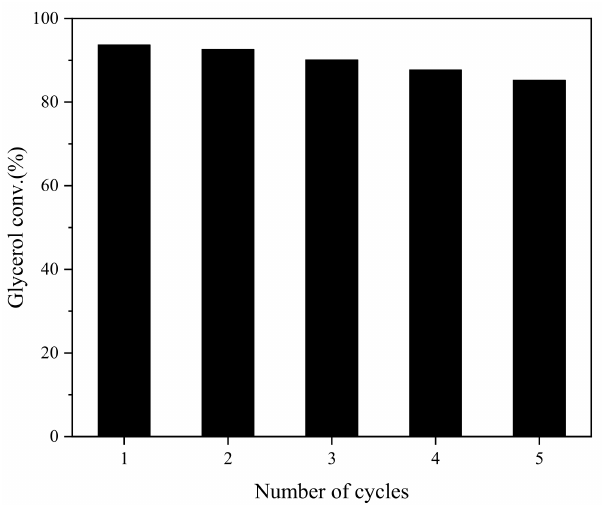
Figure 9. Reusability of β